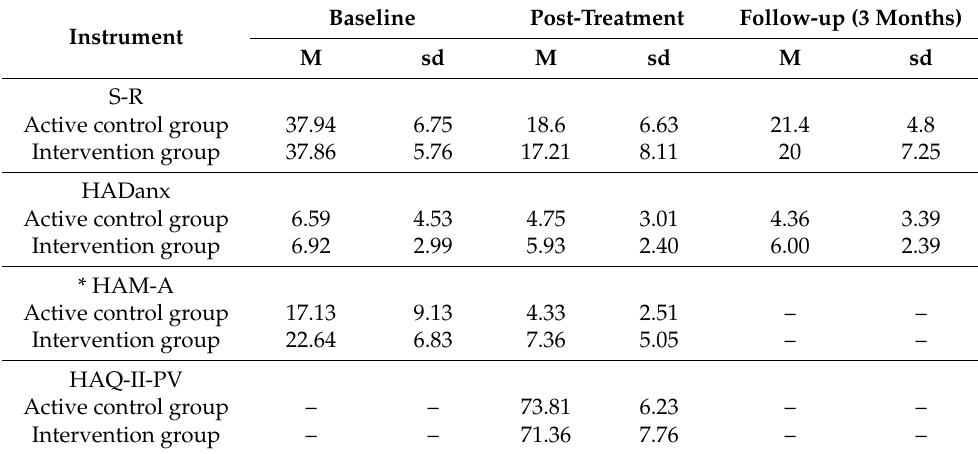
Table 2. Clinical